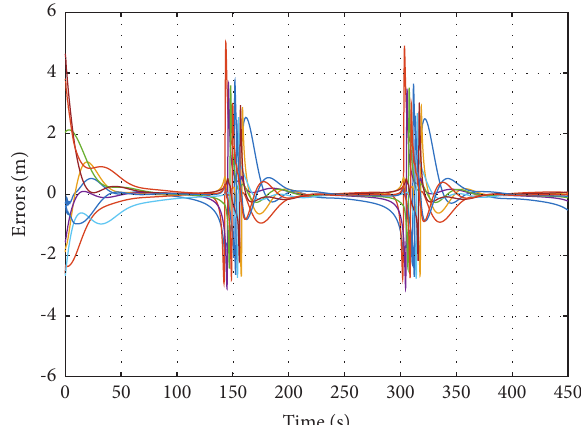
Figure 4: The tracing errors between the vehicles and their centroids.